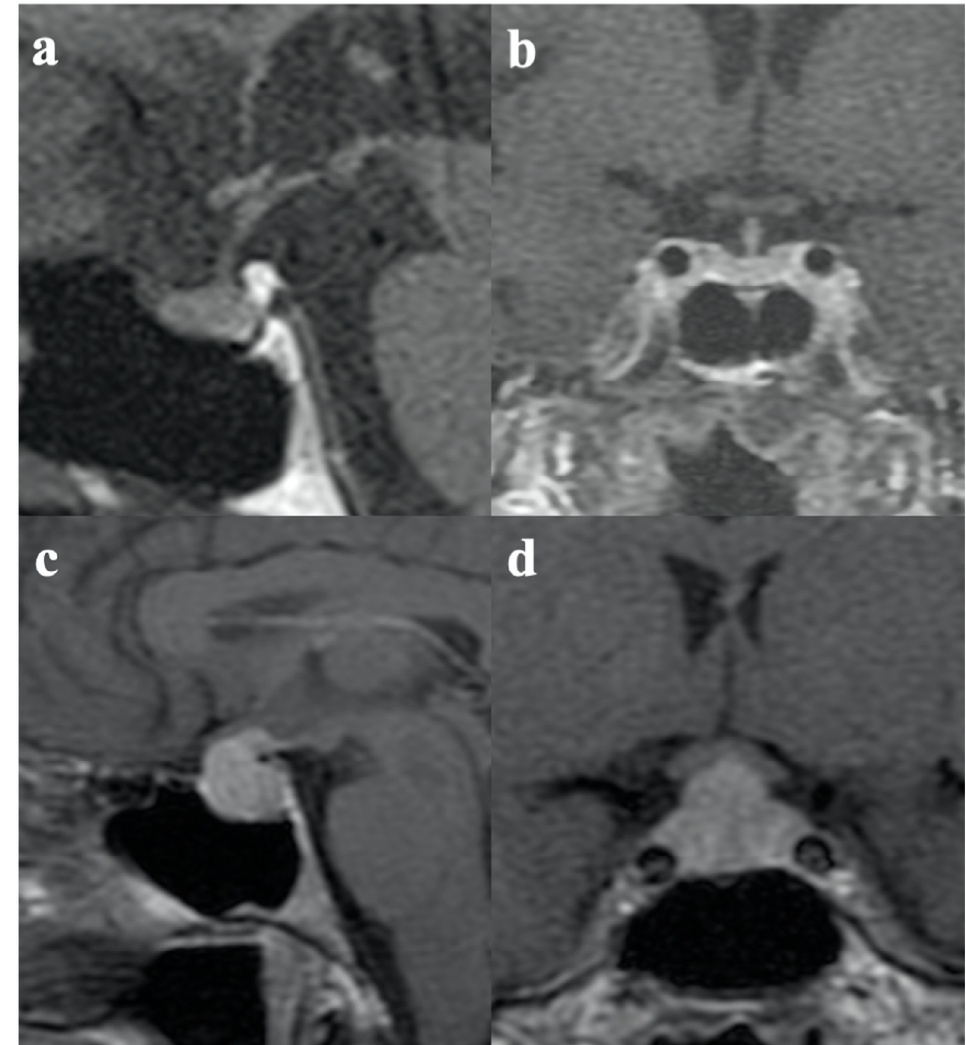
Figure 1. ( a ) Sagittal and ( b ) coronal T1-weighted images after contrast administration show normal pituitary and stalk volume and regular enhancement in a patient with ICI-induced hypoadrenalism. ( c ) Sagittal and ( d ) coronal T1-weighted images after contrast administration show typical features of hypophysitis: an enlarged pituitary gland and a thickened pituitary stalk with homogenous enhancement in a patient with IIH.